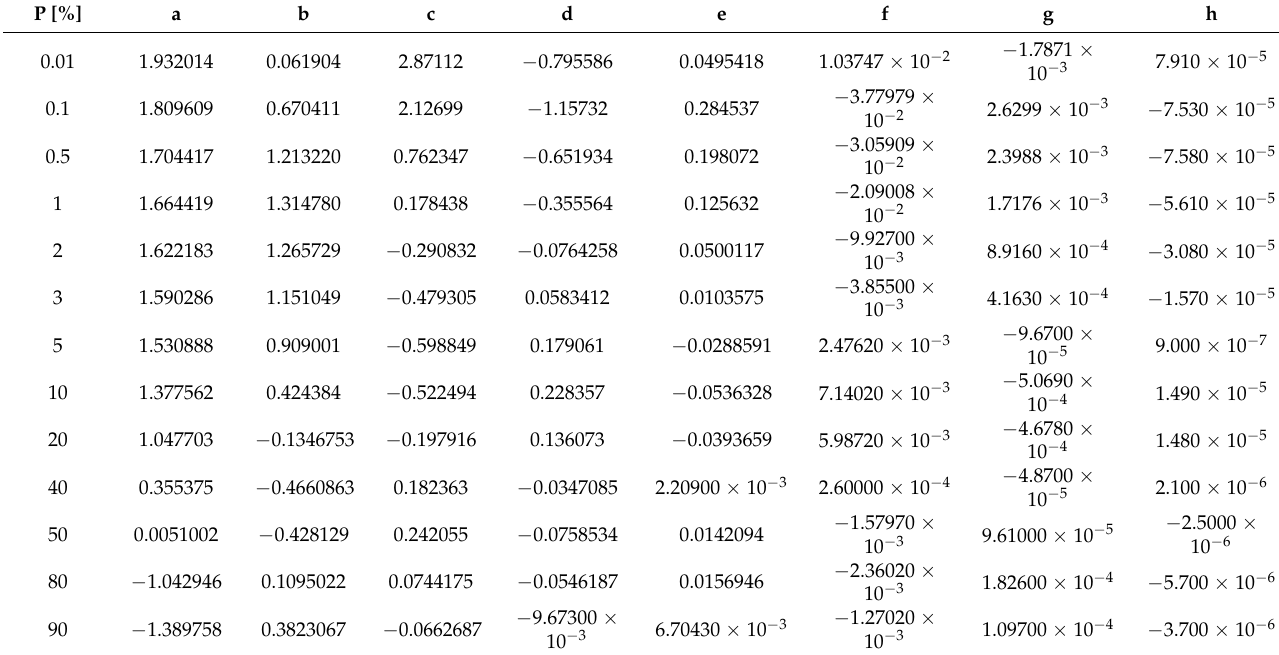
Table A4. The frequency factor for estimation with